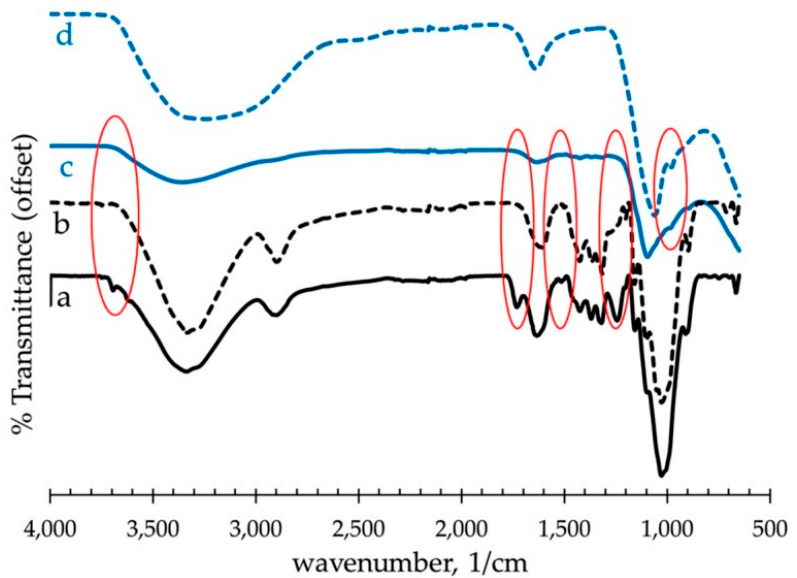
Figure 6. FTIR spectra of raw (untreated), NaOH-treated and Al 2 (SO 4 ) 3 -treated abaca fibers: ( a ) untreated abaca; ( b ) NaOH-treated abaca; ( c ) NaOH + Al 2 (SO 4 ) 3 treated abaca; and ( d ) precipitate or residue from the spent solution of Al 2 (SO 4 ) 3 treatment. The circles indicate the loss of functional groups of raw abaca fiber due to the sodium hydroxide and aluminum sulfate chemical pre-treatments. Open access under terms and conditions of the Creative Commons Attribution (CC BY), reference [15].